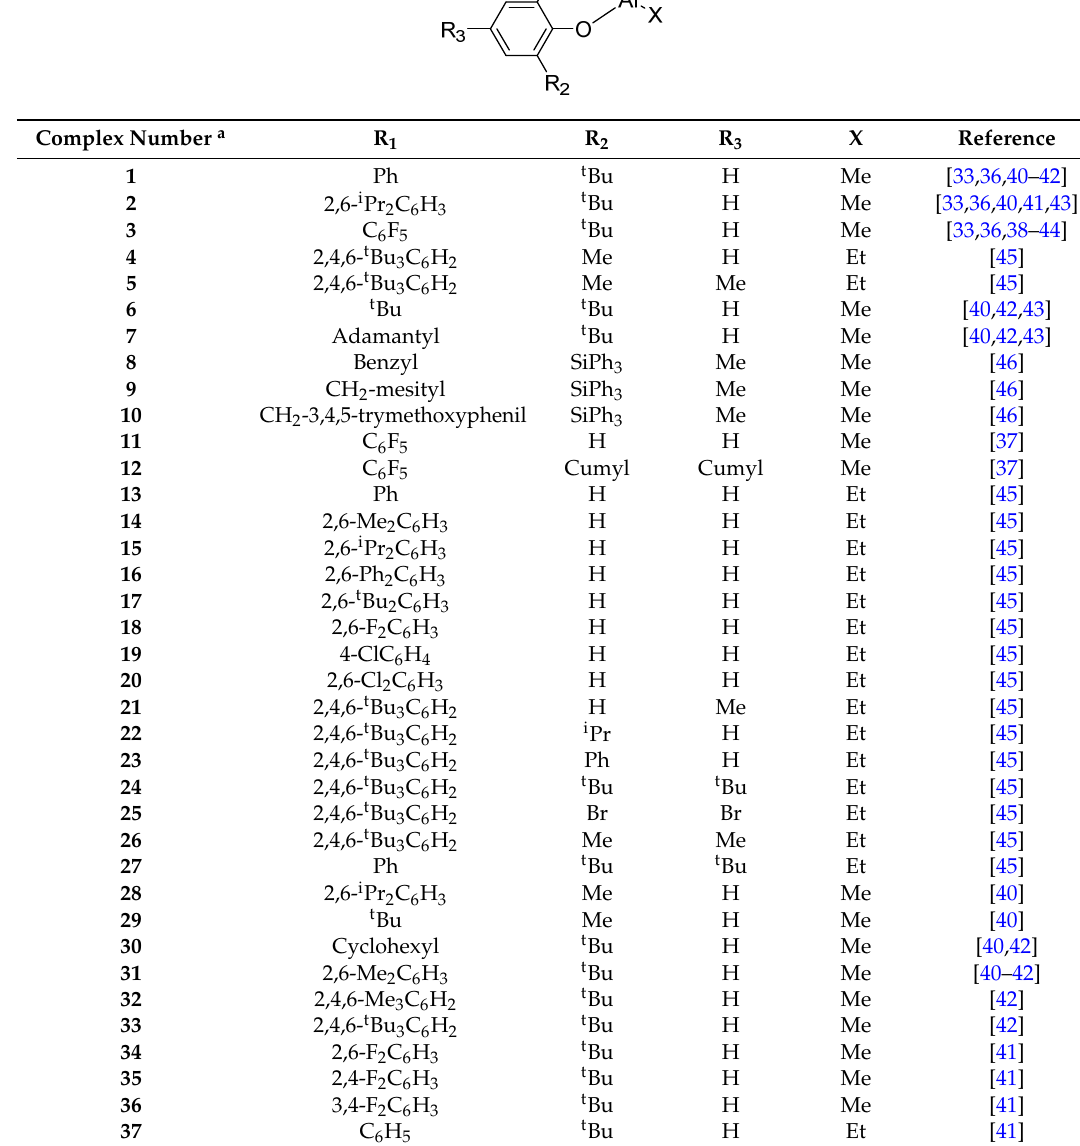
Table 1. Structural features of the (salicilaldiminato)aluminum complexes used in ring-opening polymerization (ROP) of cyclic esters.